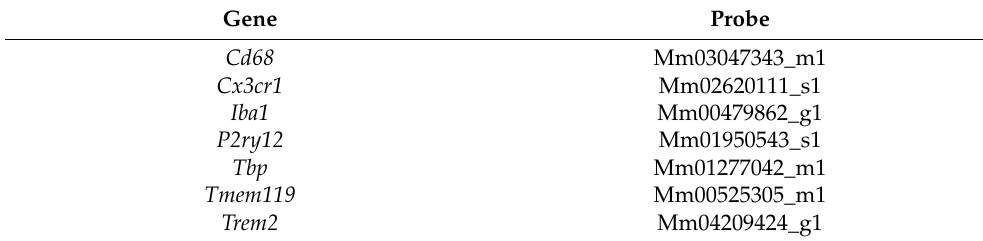
Table 1. TaqMan assays for